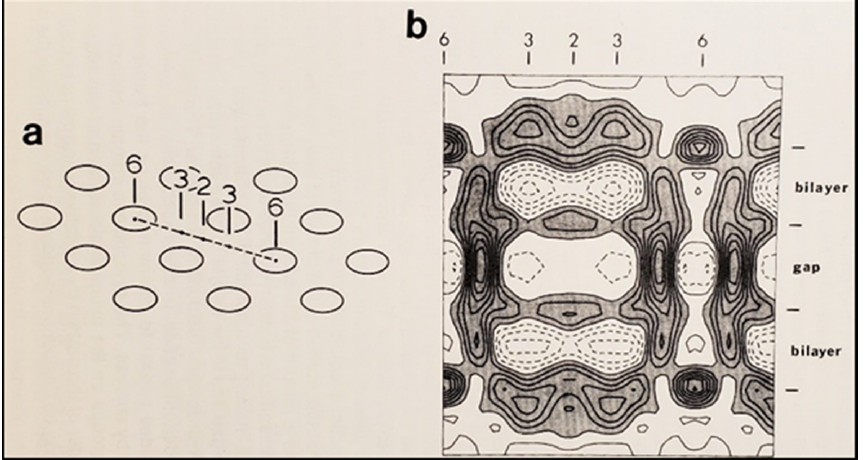
Figure 18. Diagram of the three-dimensional structure of a frozen-hydrated gap junction isolated from mouse liver and solved to 18 Å resolution by X-ray diffraction. The channel “6” in ( a , b ) is impermeable to 50% sucrose, proving that it is closed at each cytoplasmic end by a particle that prevents sucrose entry. This proves that the channels of isolated (crystalline) junctions are in closed state (Ca-CaM locked state). Reproduced from ref. [121] with permission from the Journal of Molecular Biology and the Cold Spring Harbor Laboratories.